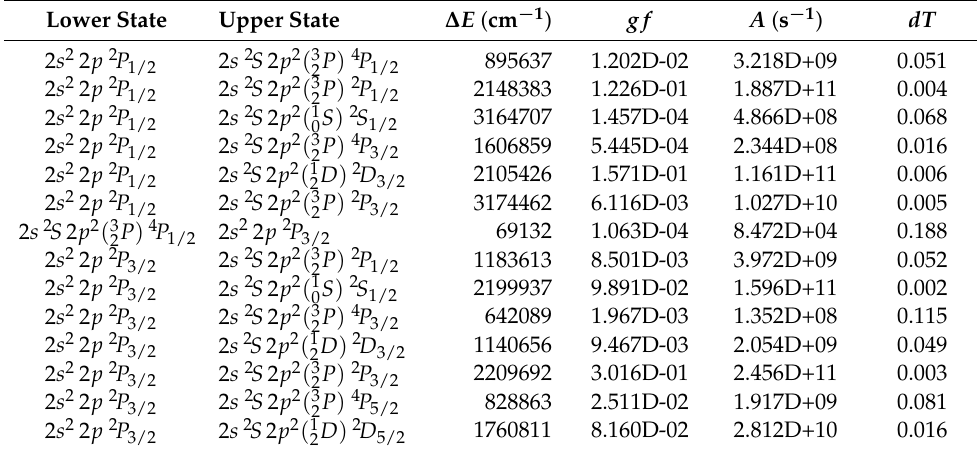
Table 10. Transition data from the file